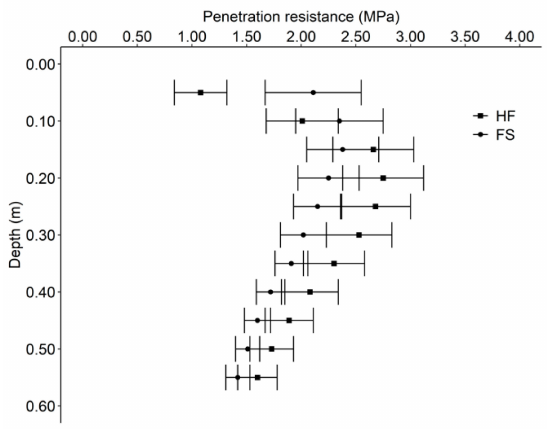
Figure 3. Soil penetration resistance (PR) up to 0.60 m depth in eucalypt cultivation areas under coppicing harvested with harvester + forwarder (HF) and feller + skidder (FS) systems. Bars refer to the confidence interval (90%) of the average (n =